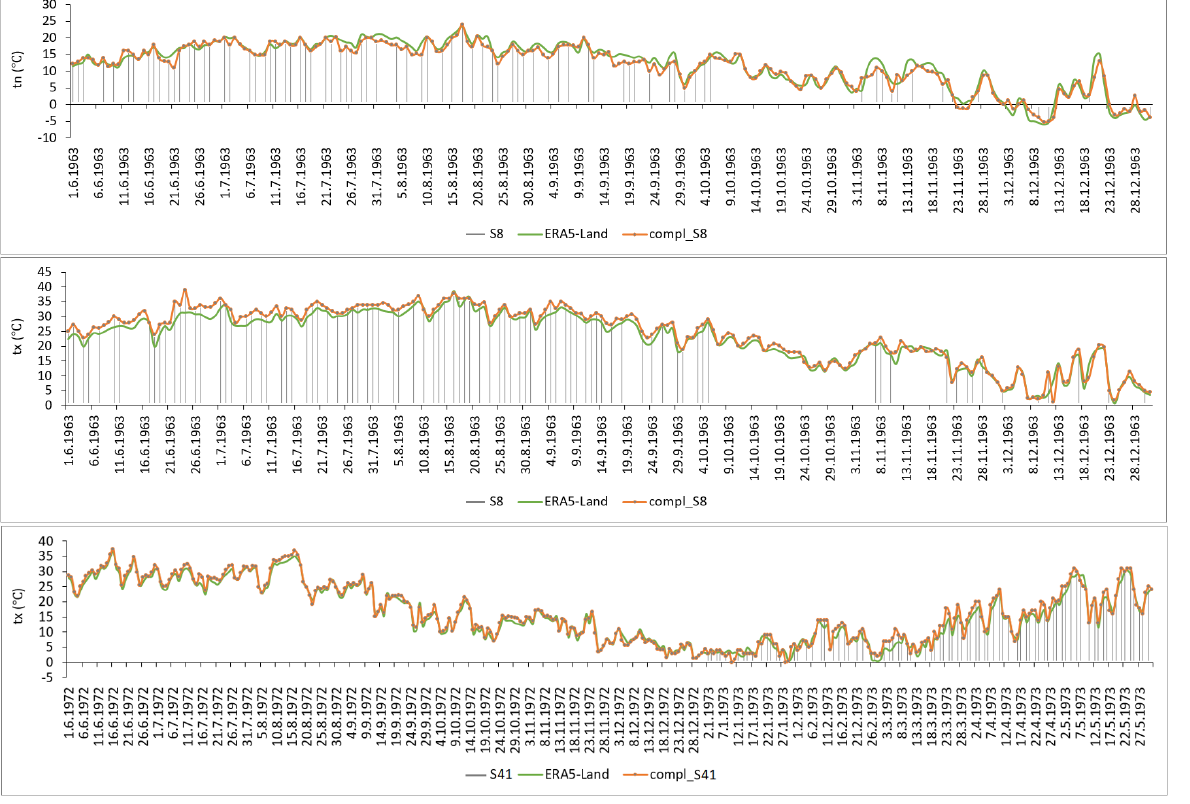
Figure A2. Upper panel: Missing values ( tn ) imputation in the case of small to medium gaps number (Edirne). Middle panel: Missing values ( tx ) imputation in the case of small to medium gaps number (Edirne). Lower panel: Missing values ( tx ) extrapolation (Skopje International Airport). tx —daily maximum temperature, tn —daily minimum